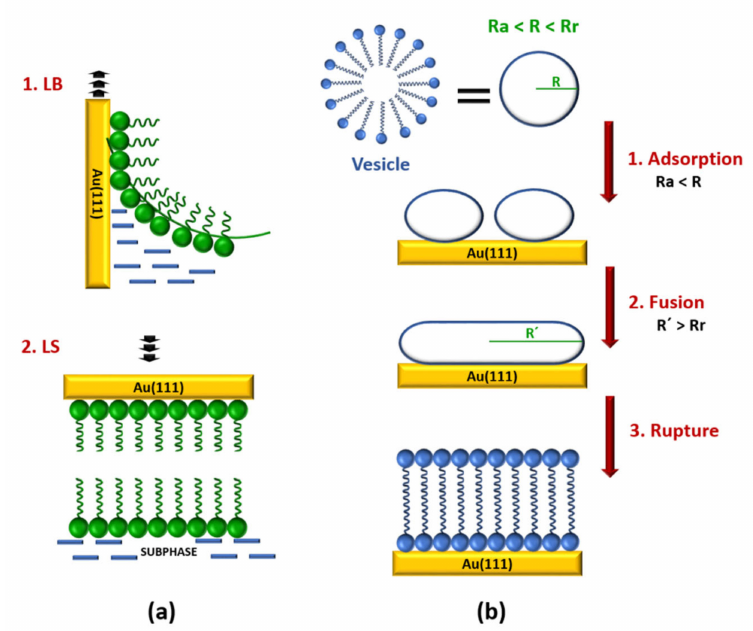
Figure 1. Schematic representation of the preparation of lipid bilayers on gold substrates by ( a ) a combination of Langmuir–Blodgett and Langmuir–Schaefer (LB-LS) methods and ( b ) vesicle fusion (VF). Adapted with permission from [11,13]. Copyright (2000 and 2007) American Chemical